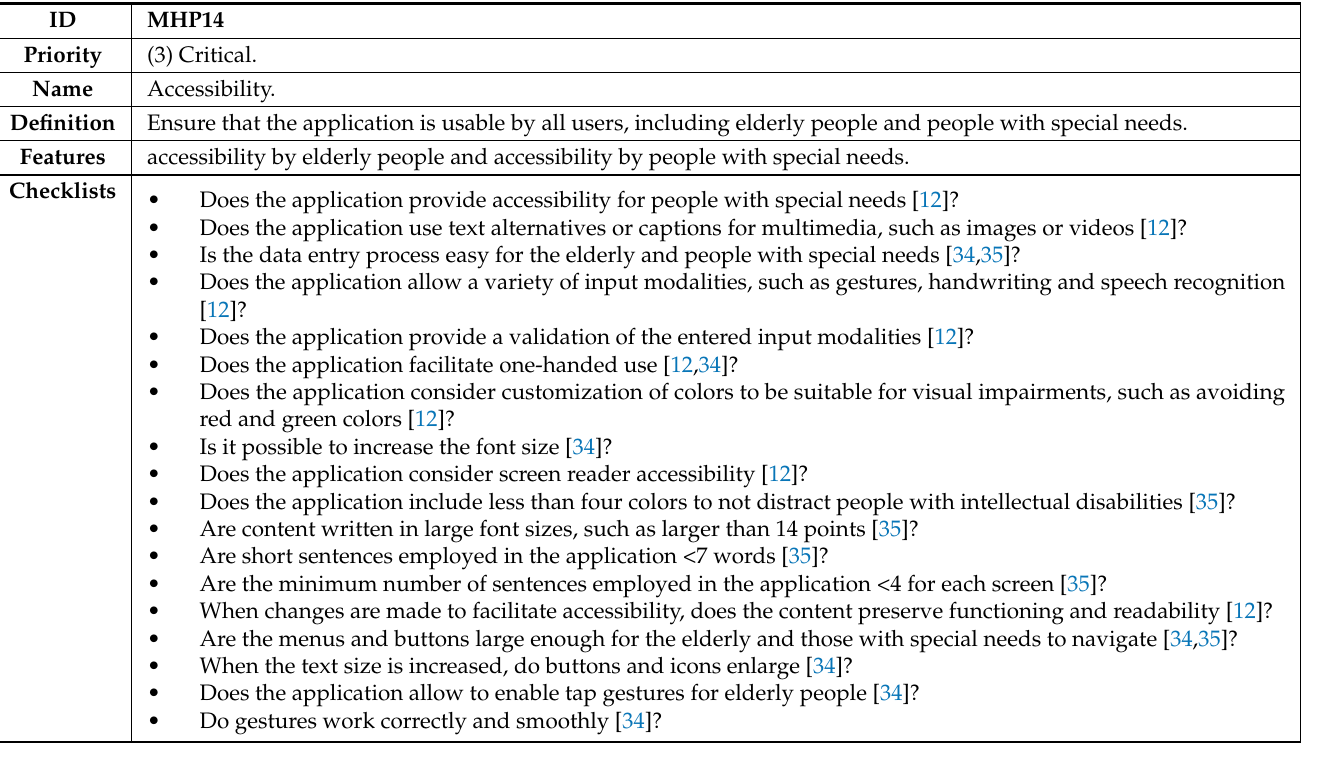
Table A14. Descriptive details of the fourteenth